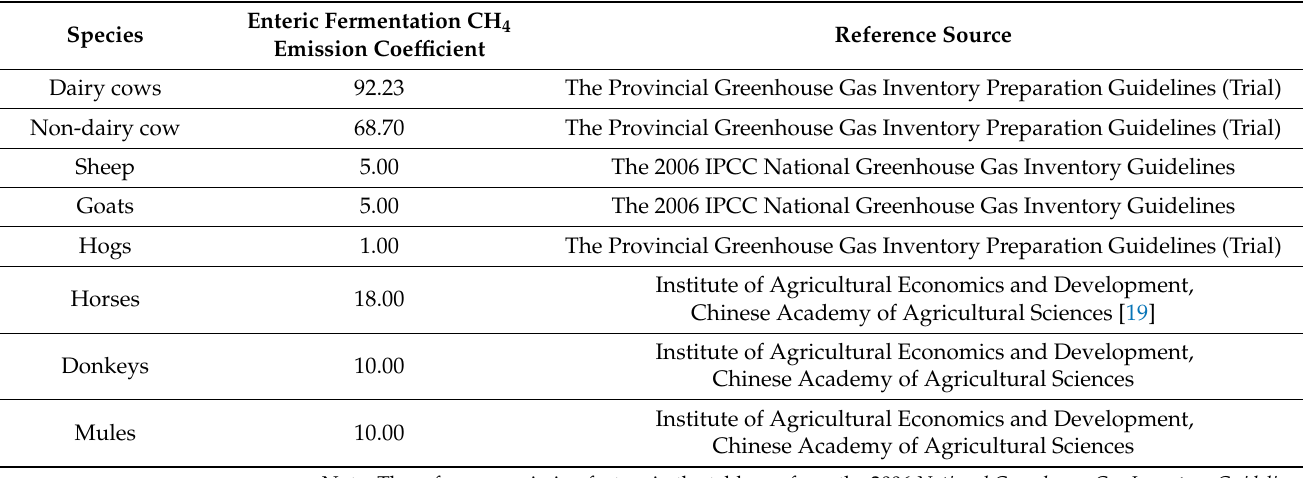
Table 1. Methane emission factors from intestinal fermentation of animals (kg/head/year).